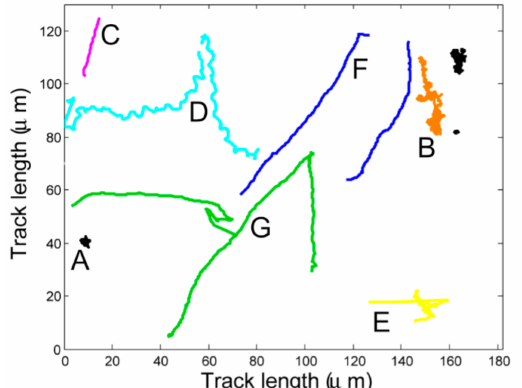
Figure 6. Representative free swimming tracks. ( A ) non-motile (black), ( B ) drifting: non-motile or dead cells that appear to move slightly, due to Brownian motion or bu ff eting by mobile cells (orange), ( C ) very short or truncated tracks due to cells moving at an angle to the plane of the field (magenta), ( D ) corkscrews: a cell rotating in such a way as to rock its centre from side to side (cyan), ( E ) jumps: software incorrectly assigning two tracks to be from the same object, leading to an inconceivably large jump between frames (yellow), ( F ) smooth swimming tracks (blue), and ( G ) wild-type run-stop-run